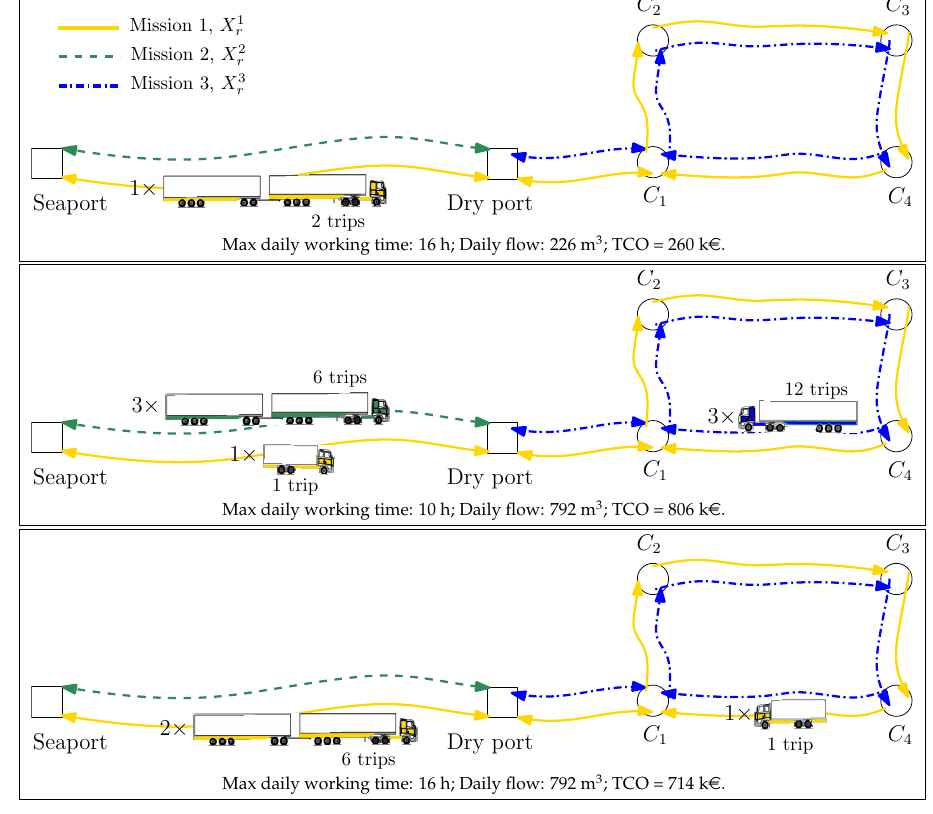
Figure 12. Optimum fleet for different maximum daily working times and freight flow. Lines between nodes illustrate routes among nodes corresponding to different